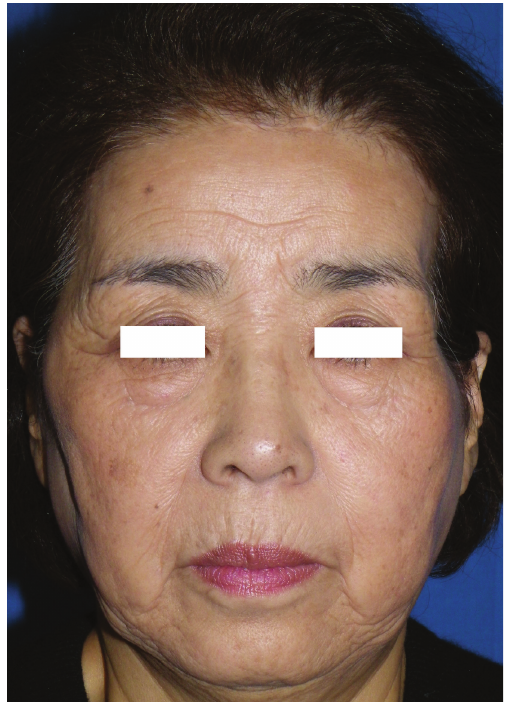
Figure 6: Postoperative view at 24 months followup.